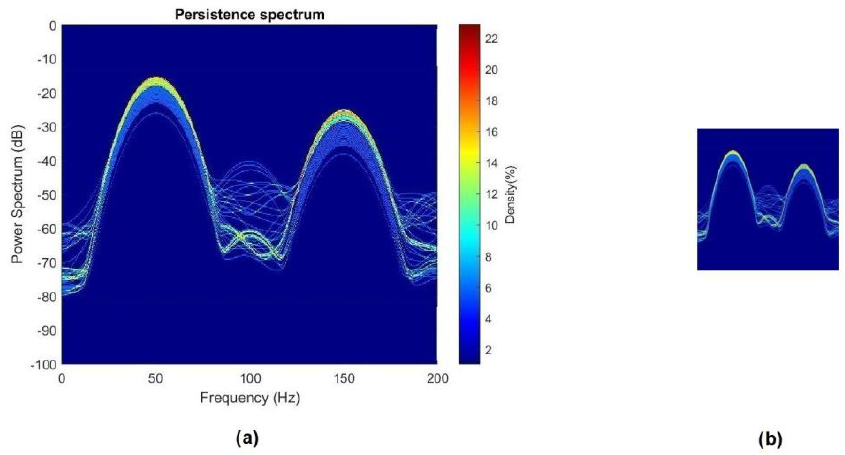
Figure 7. ( a ) PS image; ( b ) PS image cropped and resized.